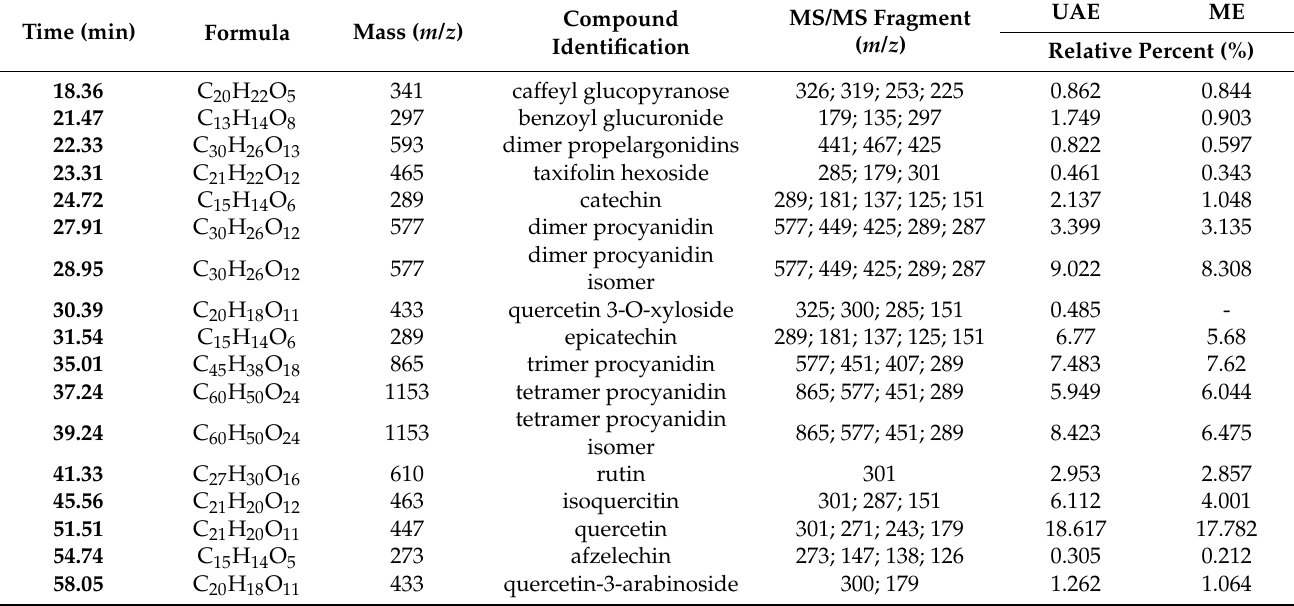
Table 4. Extracted compositions identified by